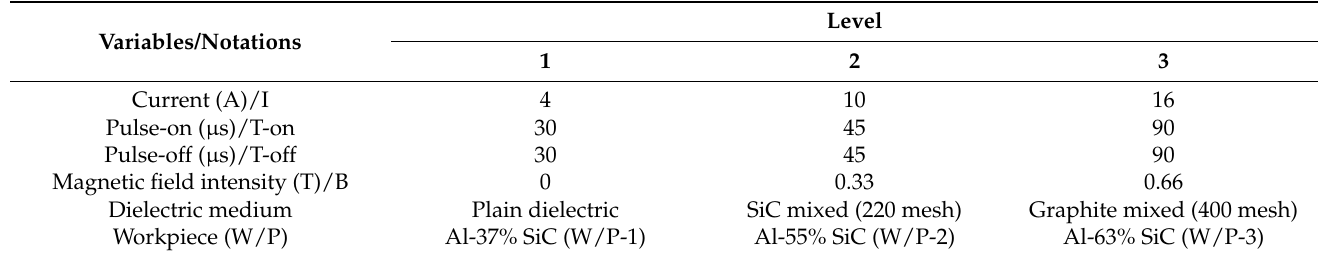
Table 2. Input parameters and their levels.